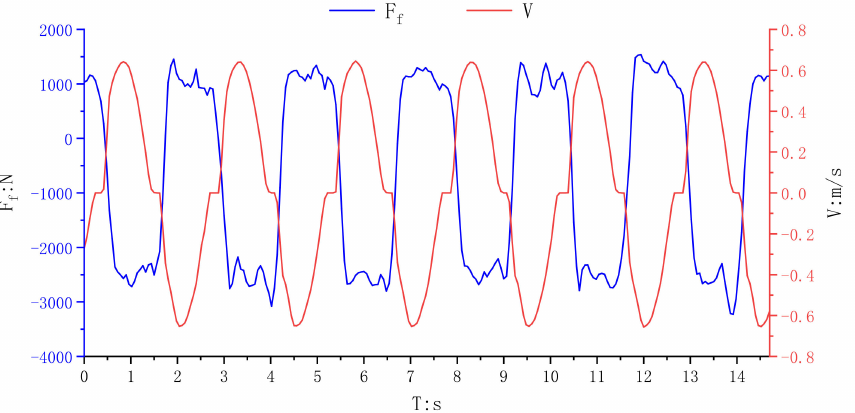
Figure 23. Friction–speed test curve of hydraulic cylinder. F f denotes the frictional force of the hydraulic cylinder; V denotes the speed of the hydraulic